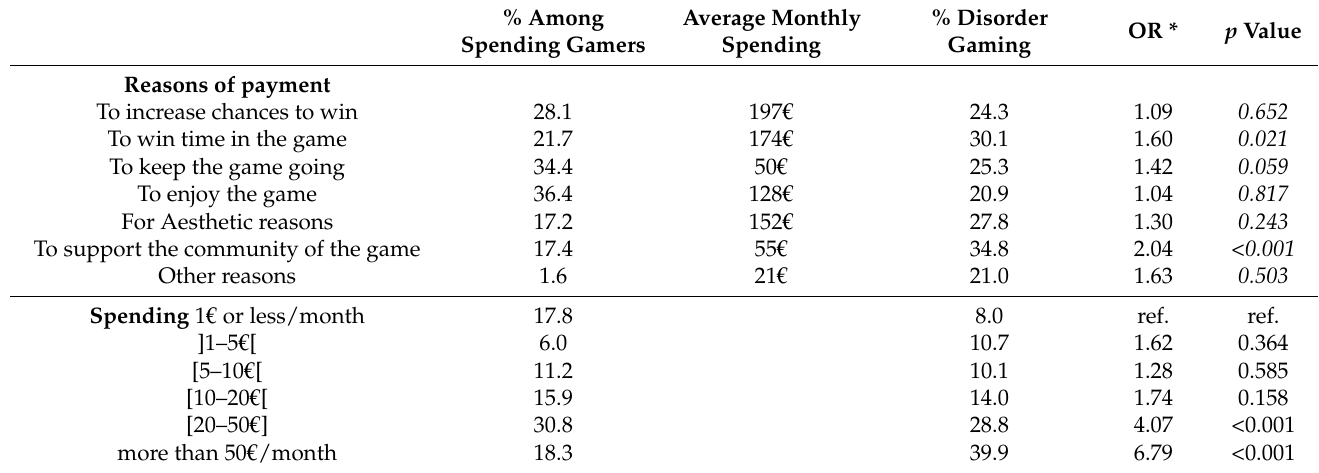
Table 4. Spending in game—reasons for payments and amounts spent. % Among Average Monthly Spending Gamers Spending